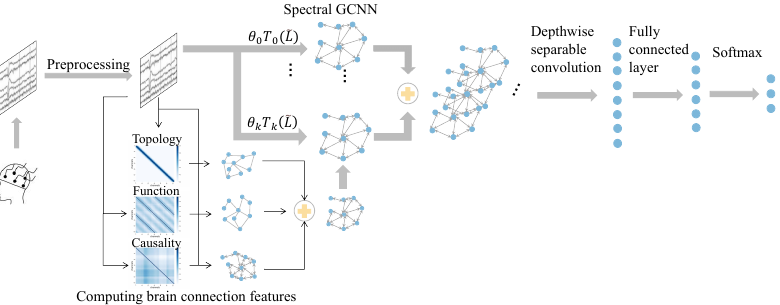
Figure 1. The flow chart of FGCN. θ k T k ( ˜ L ) denotes the Chebyshev polynomials and θ is updated during the process of graph convolutional neural